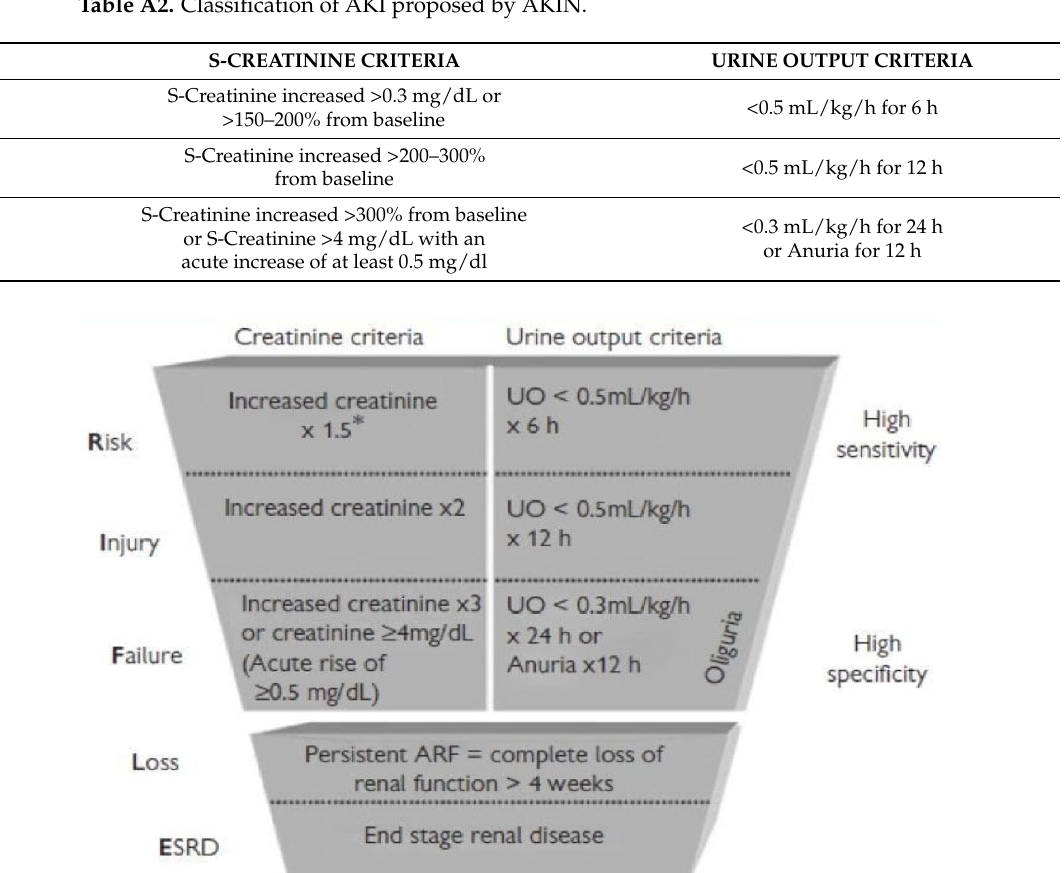
Table A2. Classification of AKI proposed by AKIN.